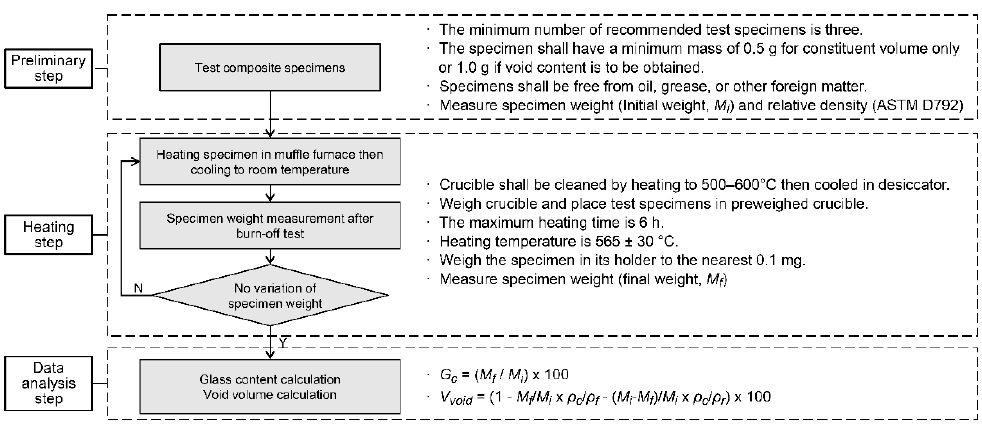
Figure 9. Burn-o ff method for the combustion of laminate specimens. Figure 9. Burn-off method for the combustion of laminate specimens. Figure 9. Burn-off method for the combustion of laminate specimens.